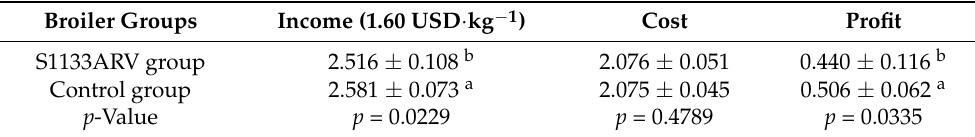
Table 3. Cost–benefit analysis of using the S1133ARV vaccine strain in female broilers.